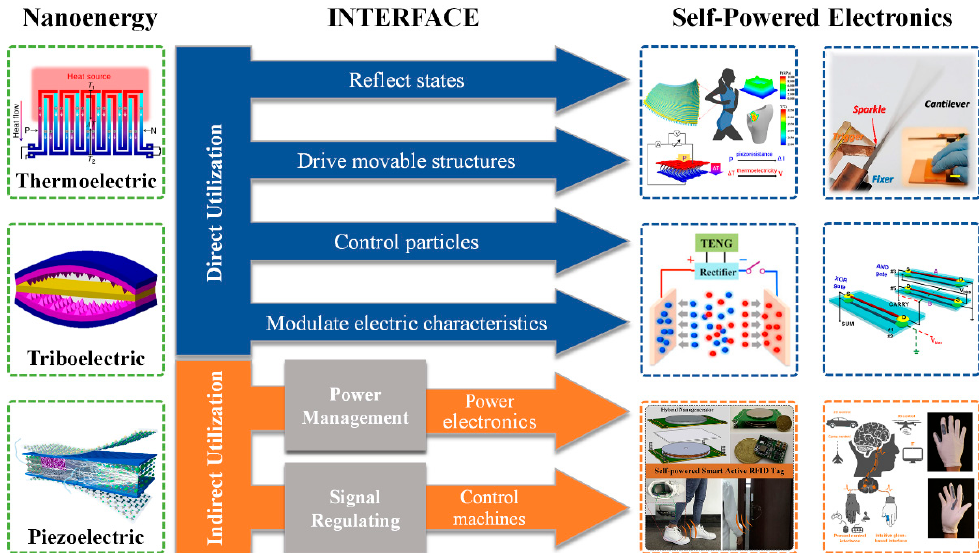
Figure 7. The interface between nanoenergy and self-powered electronics. Various kinds of nanoenergy, such as thermoelectric energy, triboelectric energy, and piezoelectric energy, are proposed to be used for self-powered electronics. The method of applying nanoenergy to self-powered electronics is described as the interface, which includes direct utilization and indirect utilization. For direct utilization, nanoenergy can realize active sensing, driving movable structures, controlling particles, and modulating electric characteristics. For indirect utilization, nanoenergy can power electronics and control machines with several intermediate steps such as power management modules and signal regulating process. Reproduced with permission from John Springer Nature [82], Elsevier [31,48,60,78,83], and American Chemical Society [47,68,84].